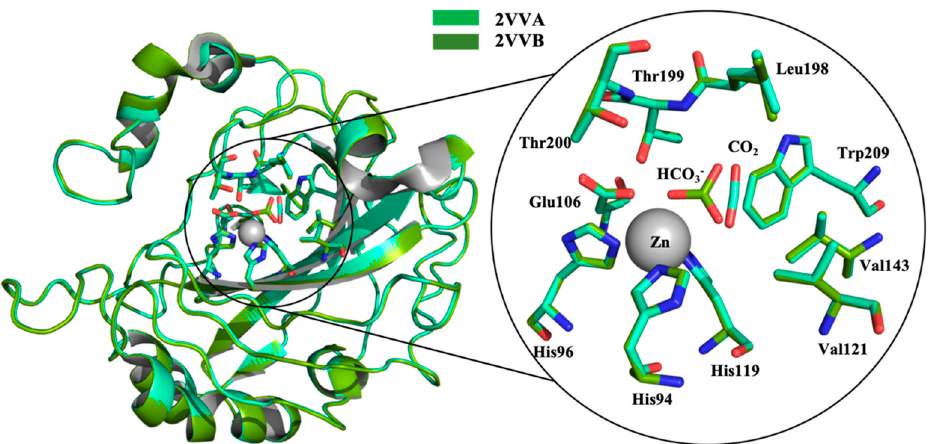
Figure 2. Superposition of CA II crystal structure in complex with CO 2 (pdb 2VVA) and HCO 3 − (pdb 2VVB); limegreen and splitpea, respectively. In the circle, focus of the catalytic domain.